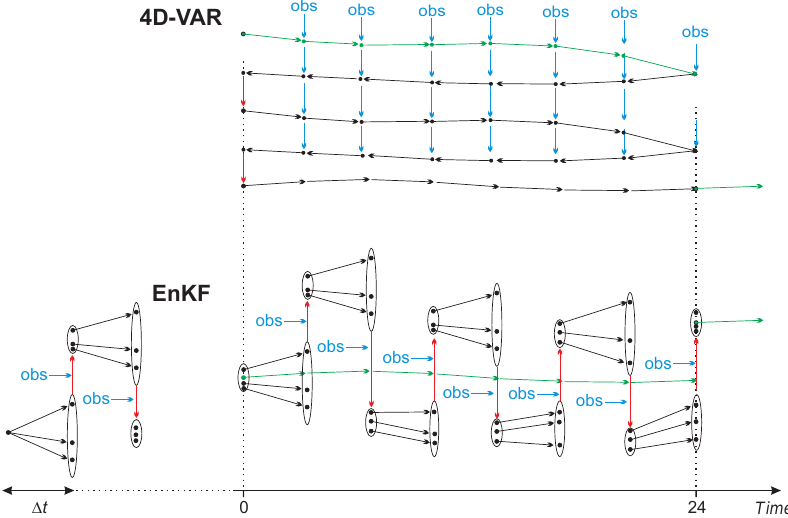
Figure 1. Schematic representation of the practical implementation of the 4D-VAR (top) and EnKF (bottom) assimilation methods in BAS- COE. Black dots represent model state and observational information is depicted in blue. The black arrows represent model integrations by one time step, vertical red arrows represent model state optimization (4D-VAR) or Kalman filter (EnKF). Green dots represent the analyses at 0h which are used as initial conditions for the diagnostic 24h forecasts (green arrows). For clarity, the number of 4D-VAR iterations has been limited to two and the number of EnKF members has been limited to